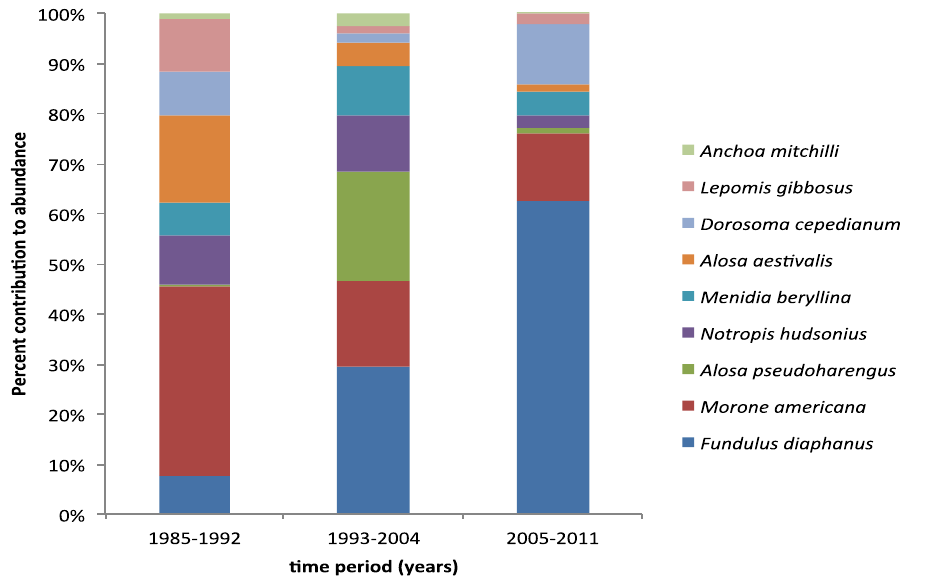
Figure 6. Relative abundance of the species that contribute at least 5% to the differences in fish community structure between the three time periods. Species are displayed in ascending order of total abundance from top to bottom.